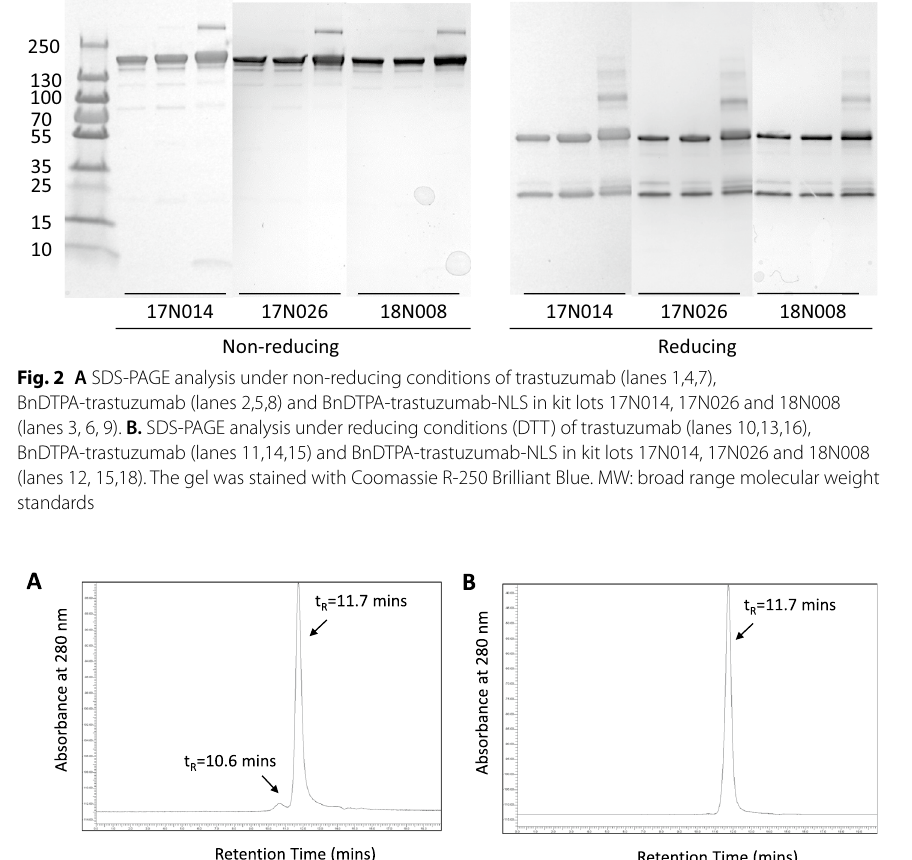
(MW 50 kDa and 25 kDa) corresponding to the heavy and light immunoglobulin = chains while the bands for BnDTPA-trastuzumab-NLS (lanes 12/15/18) migrated at slightly higher MW of 55 and 28 kDa, respectively. There was a faint higher MW band (MW 110 kDa) for BnDTPA-trastuzumab-NLS but not for trastuzumab or = BnDTPA-trastuzumab, which may represent reduced cross-linked immunocon- jugates following Sulfo-SMCC conjugation. SE-HPLC analysis of a representative lot (17N014) of kits (Fig. 3A) showed one major peak (> 90%) for BnDTPA-trastu- zumab-NLS with a t R 11.7 min and a small secondary peak at t R 10.6 min (< 10%). = = This small peak may represent cross-linked immunoconjugates due to reaction with 11.7 min (Fig. 3B). The Sulfo-SMCC. Trastuzumab eluted as a single peak with t R = labeling efficiency of the kits with 111 In was consistently very high: 99.0%, 98.4% and 98.6% for kit lots 17N014, 17N026 and 18N008, respectively, and met specifica- tions for labeling efficiency ( 90%; Table 1). 111 In[In]-BnDTPA-trastuzumab-NLS ≥